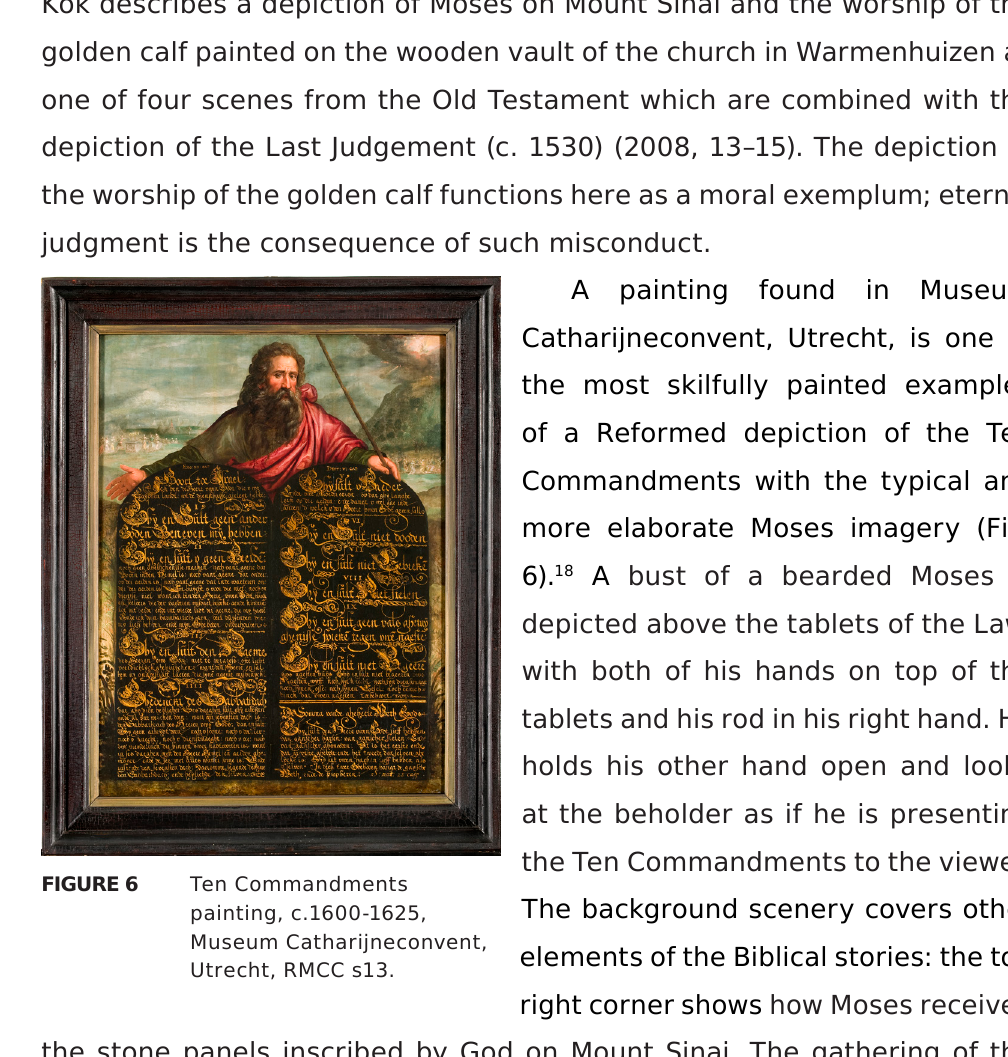
the stone panels inscribed by God on Mount Sinai. The gathering of